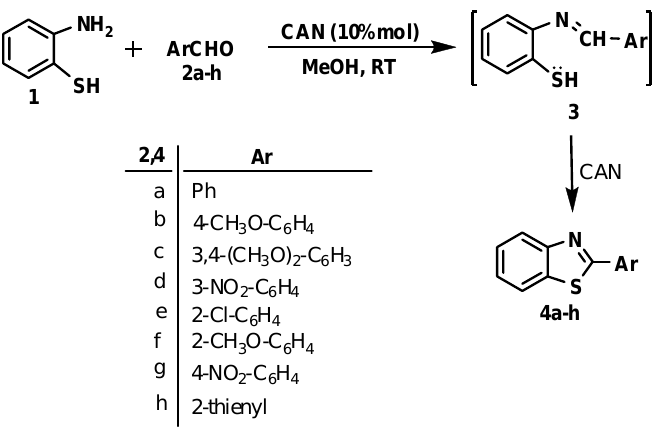
Figure 1 . One-pot synthesis of 2-arylbenzothiazoles